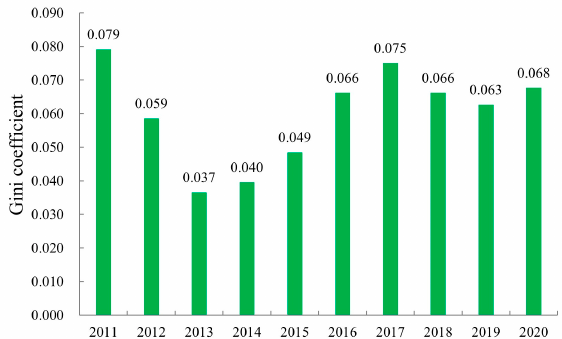
Figure 3. Gini coefficient of agricultural Tfpch during 2011–2020.